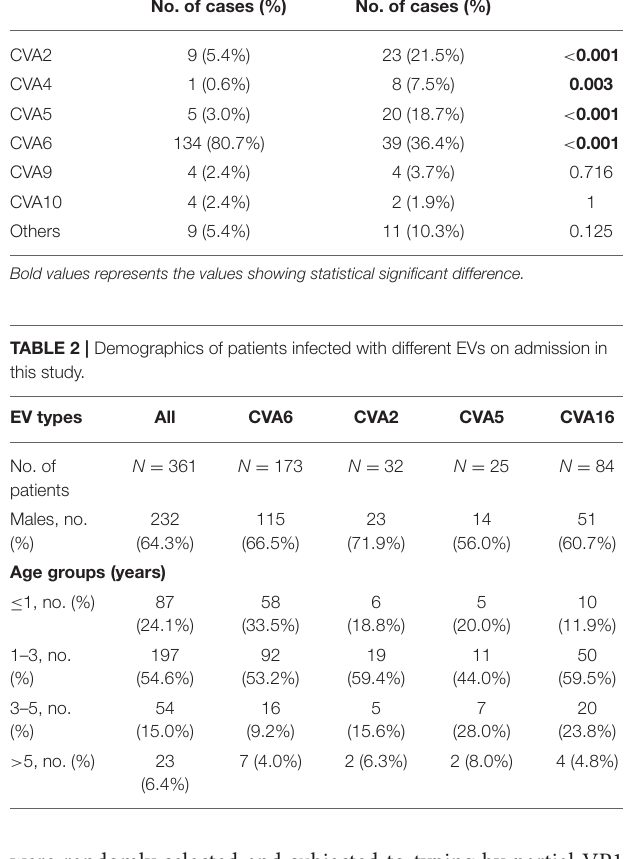
TABLE 1 | The prevalence frequency of non-EV-A71/CVA16 EVs in HFMD/HA cases. EV types